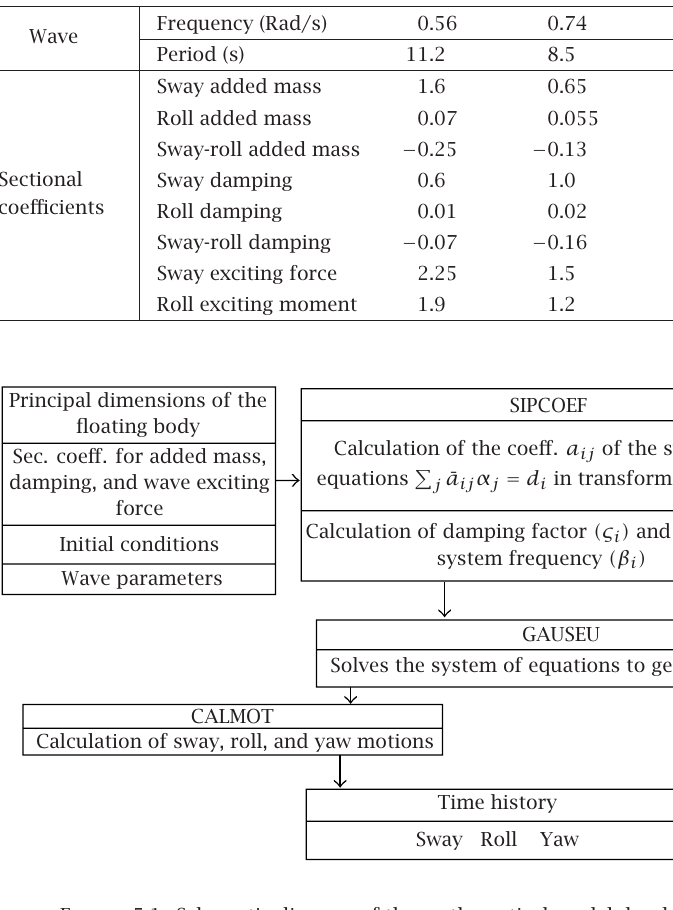
Figure 5.1 . Schematic diagram of the mathematical model